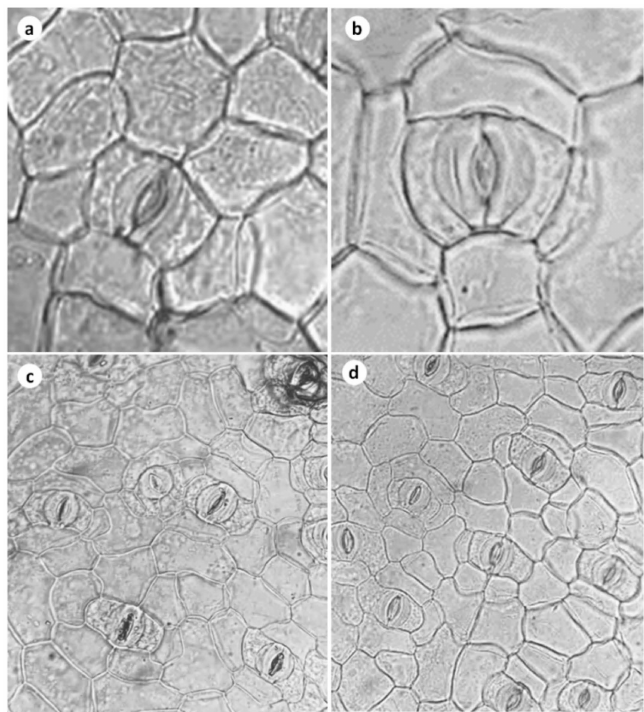
Figure 5. Stomatal density in non-AMF ( a , c ) and AMF-treated ( b , d ) Philodendron after 8 weeks of acclimatization (40 ×